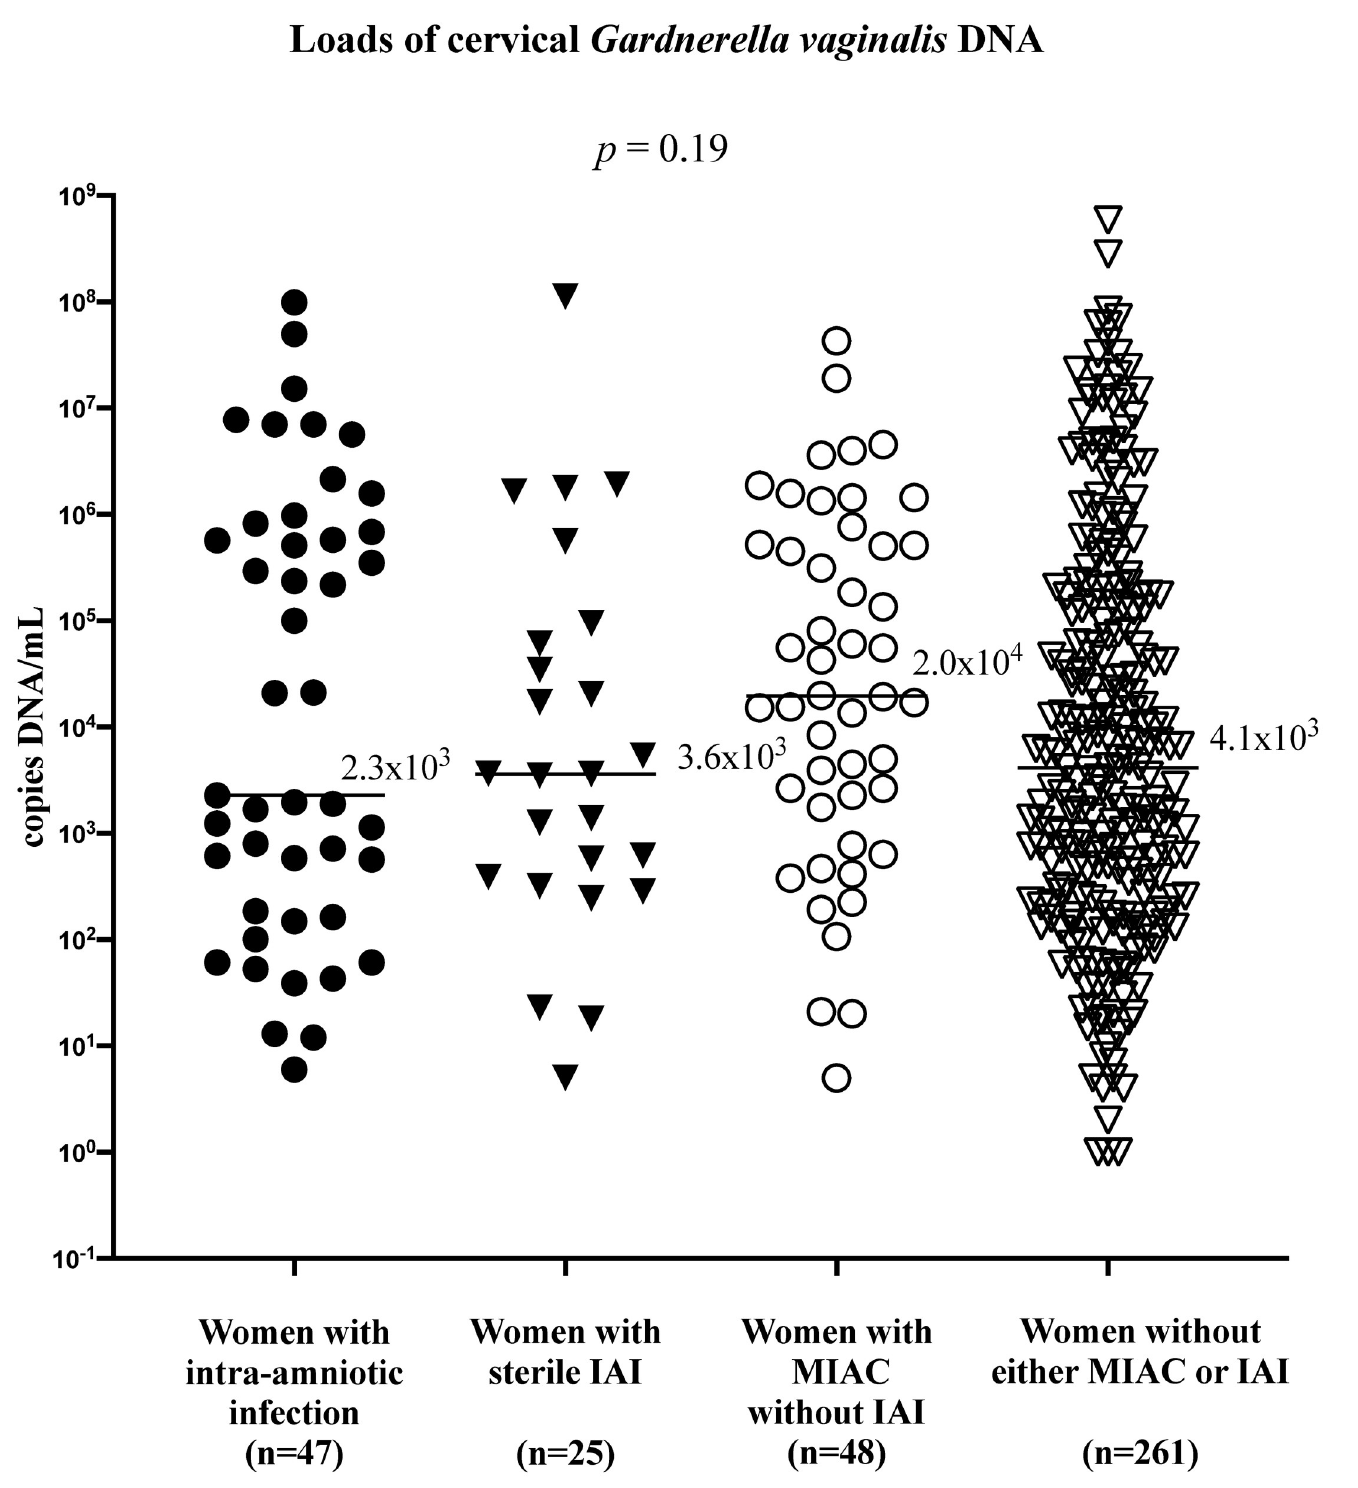
Fig 3. Loads of G . vaginalis DNA in women with preterm prelabor rupture of the membranes with the cervical presence of G . vaginalis DNA with respect to the presence of microbial invasion of the amniotic cavity and/or intra-amniotic inflammation. No differences in the cervical loads of G. vaginalis DNA was revealed among women with intra-amniotic infection, with sterile IAI, with MIAC without IAI and without either MIAC or IAI ( p = 0.19). Abbreviations: IAI, intra-amniotic inflammation; MIAC, microbial invasion of the amniotic cavity.